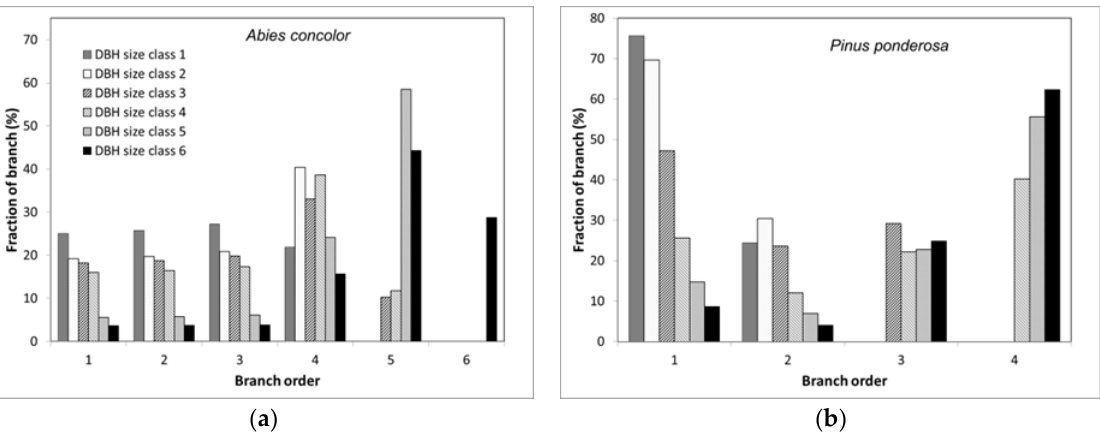
Figure 2. Relative contribution of branch orders to branch volume for ( a ) Abies concolor (Gord. & Glend.) Lindl. ex Hildebr. and ( b ) Pinus ponderosa Dougl. ex Laws. for range of DBH size classes. These values are from the model that used the highest order branches found on a species-DBH size class combination.